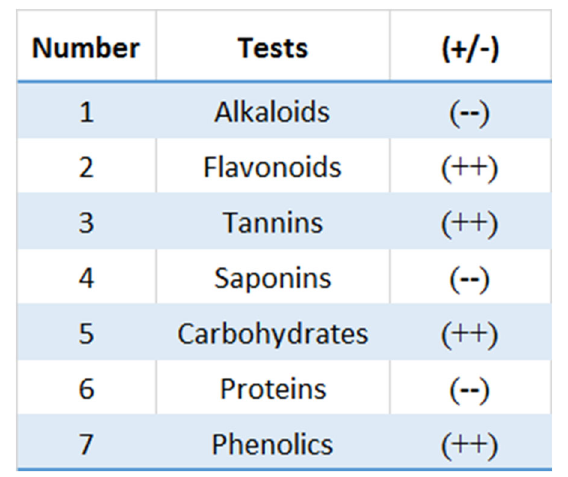
Table 1 Phytochemical Screening. The table shows the presence (++) or absence ( − -) of the screened phytochemicals in the plant